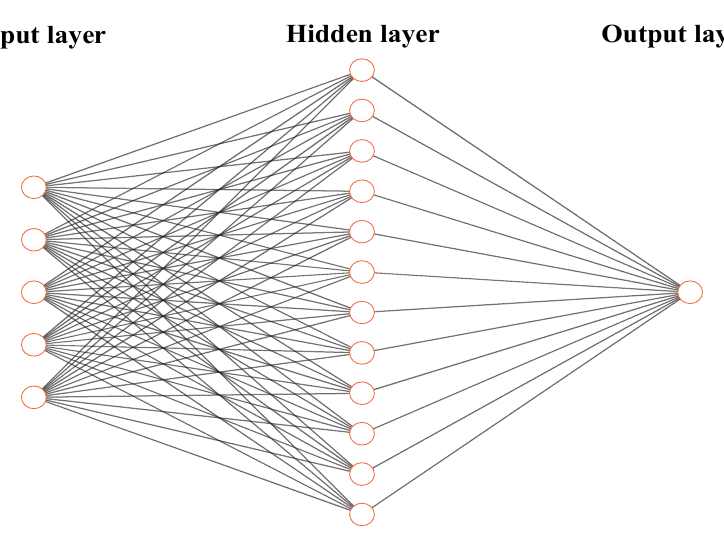
Figure 9. BP neural network